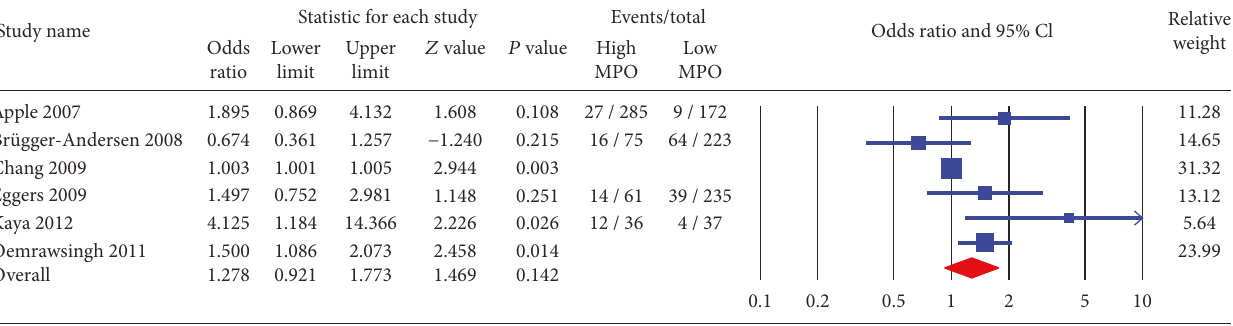
Figure 3: Forest plot for major adverse cardiac events (MACE). High myeloperoxidase showed a trend towards higher risk of MACE (odds ratio 1.27; CI: 0.92-1.77, P = 0 14 ).